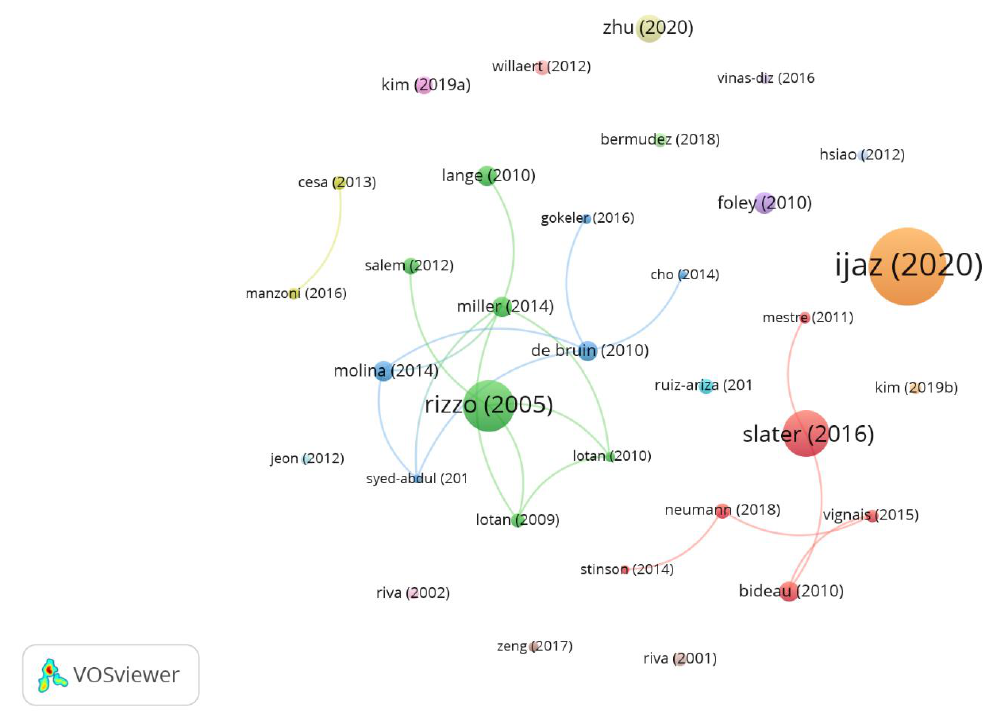
Figure 6. Most cited documents and their connections. Analysis: association strength, attraction: 6; repulsion: − 2, node size: citations, colour: cluster.